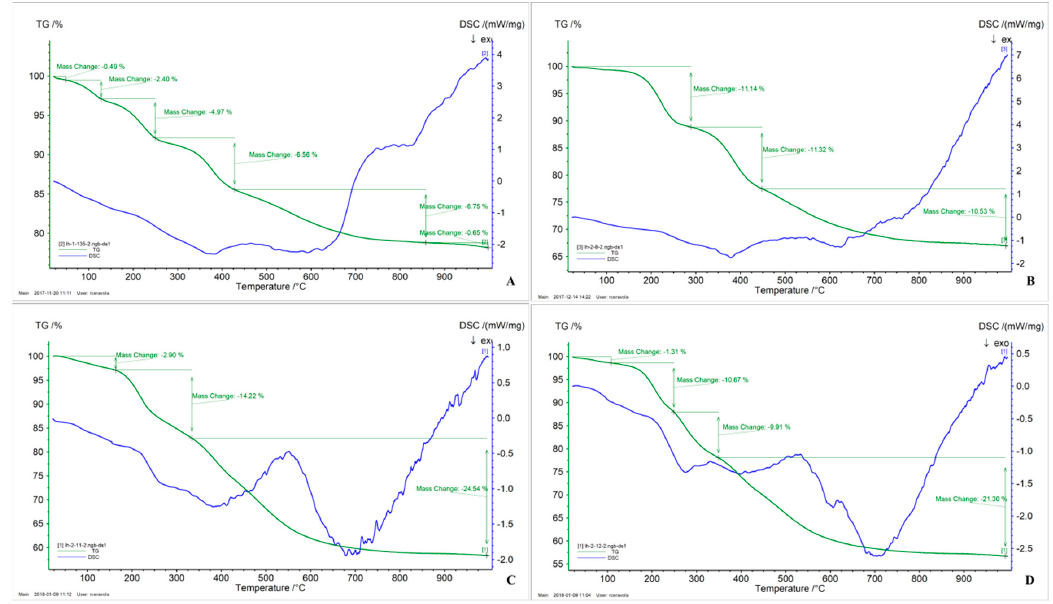
Figure 5. 13 C-CP-MAS solid-state NMR of E-P2 75 / 25 . Figure 5. 13 C ‐ CP ‐ MAS solid ‐ state NMR of E ‐ P2 75/25 .